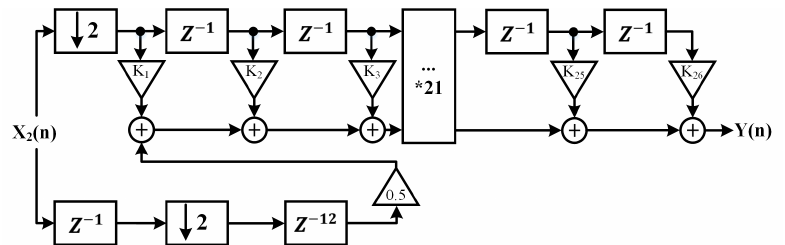
Figure 6. Structure of the multiphase half-band